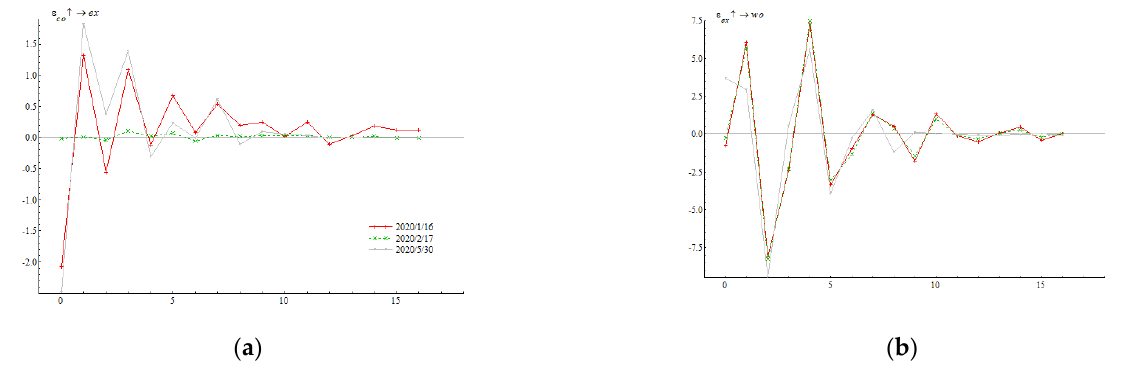
Figure 7. Impulse responses at different points for the set COVID-19, exchange rate, and log prices. Note: The abscissa refers to the number of lag periods of the impact, and the ordinate indicates the impulse response values after the shock of one-unit standard deviation. The figure shows the impulse response of exchange rate to the pandemic ( a ) and the impulse response of log prices to exchange rate ( b ) at different points.